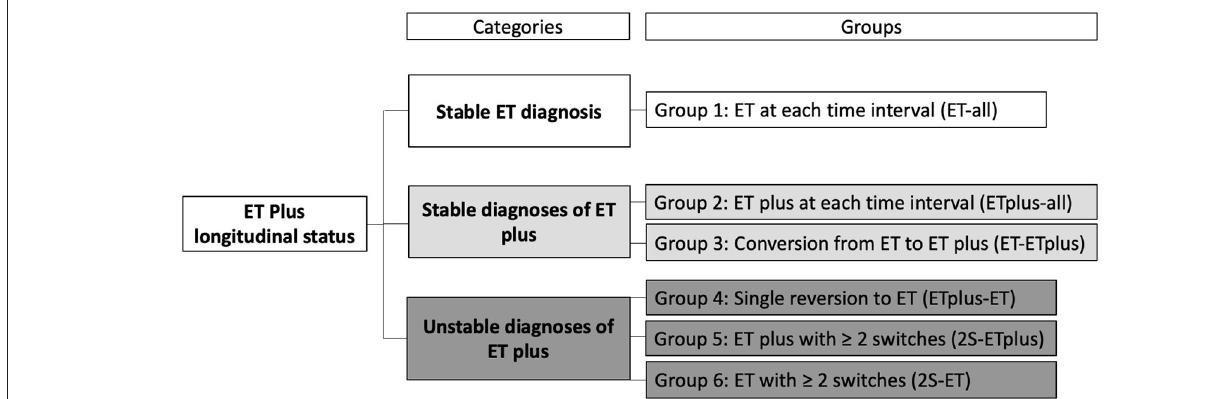
FIGURE 1 | Classification of ET and ET plus diagnoses over time.